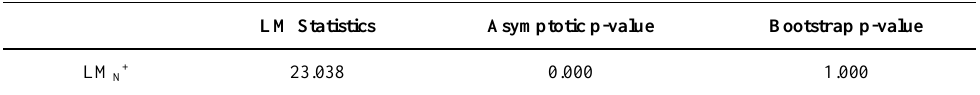
Table 5. Cointegration Test